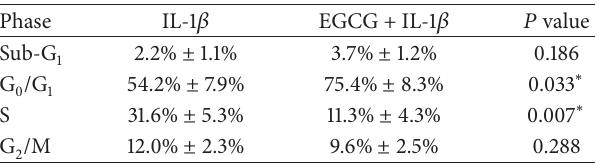
Table 1: Effect of EGCG on the cell cycle distribution in IL-1 𝛽 - treated HASMCs.